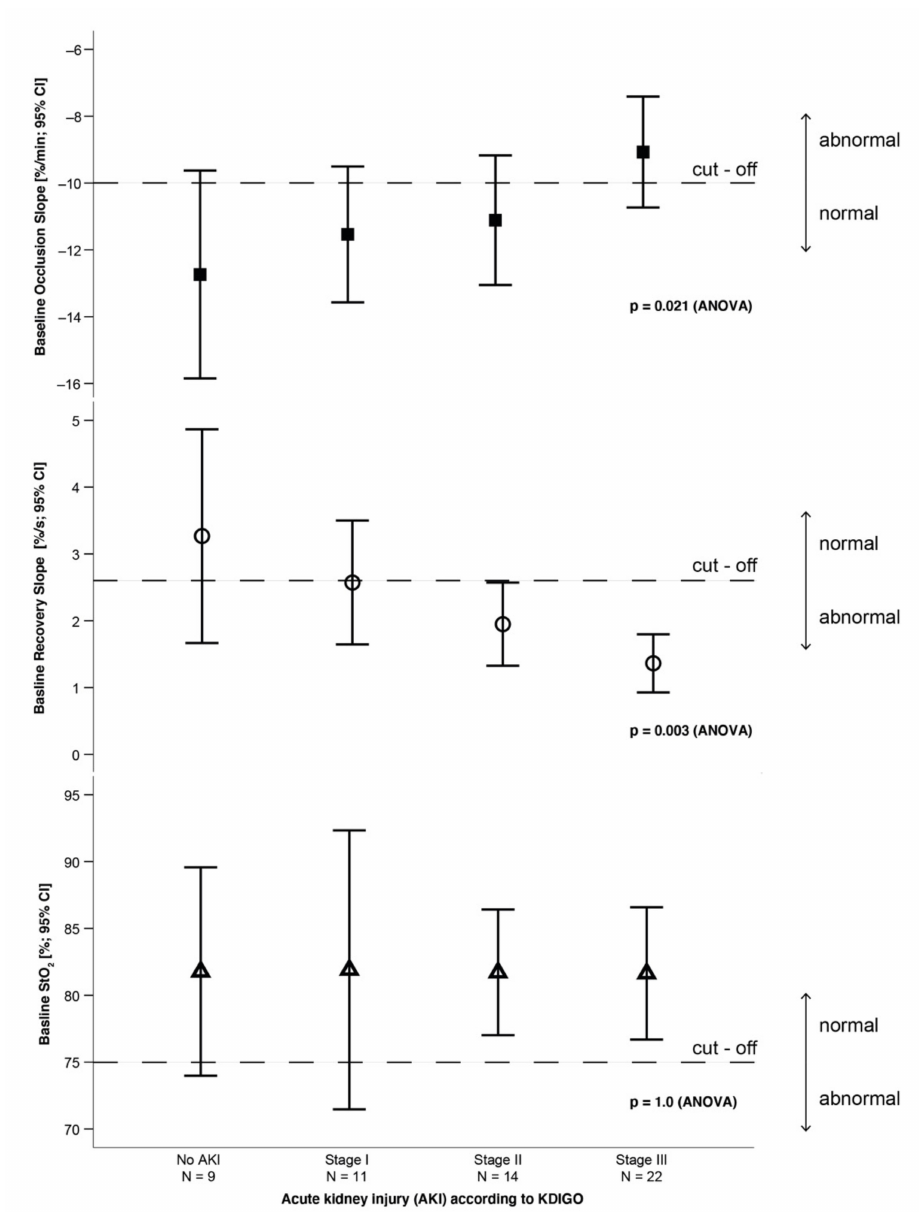
Figure 2. Mean ± standard deviation for unprovoked StO 2 and the VOT parameters OS and RS at baseline, regarding the stages of acute kidney injury (AKI) according to Kidney Disease: Improving Global Outcomes (KDIGO) criteria. Bonferroni correction for OS: no AKI vs. AKI stage III, p = 0.036; no AKI vs. AKI stage I/AKI stage II, p > 0.05; AKI stage I vs. AKI stage II/AKI stage III, p > 0.05. Bonferroni correction for RS: no AKI vs. AKI stage III, p = 0.007; no AKI vs. AKI stage I/AKI stage II, p > 0.05; AKI stage I vs. AKI stage II/AKI stage III, p > 0.05. Bonferroni correction for unprovoked StO 2 : no AKI vs. AKI stage III, p > 0.05; no AKI vs. AKI stage I/AKI stage II, p > 0.05; AKI stage I vs. AKI stage II/AKI stage III, p >